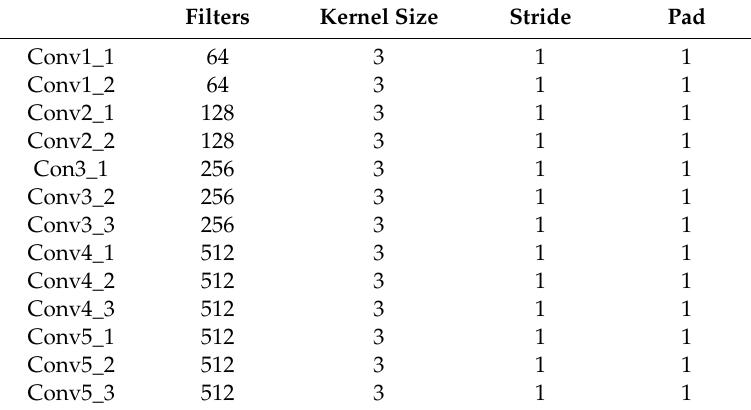
Table 2. The VGG16 network parameters for each convolutional layer. Filters Kernel Size